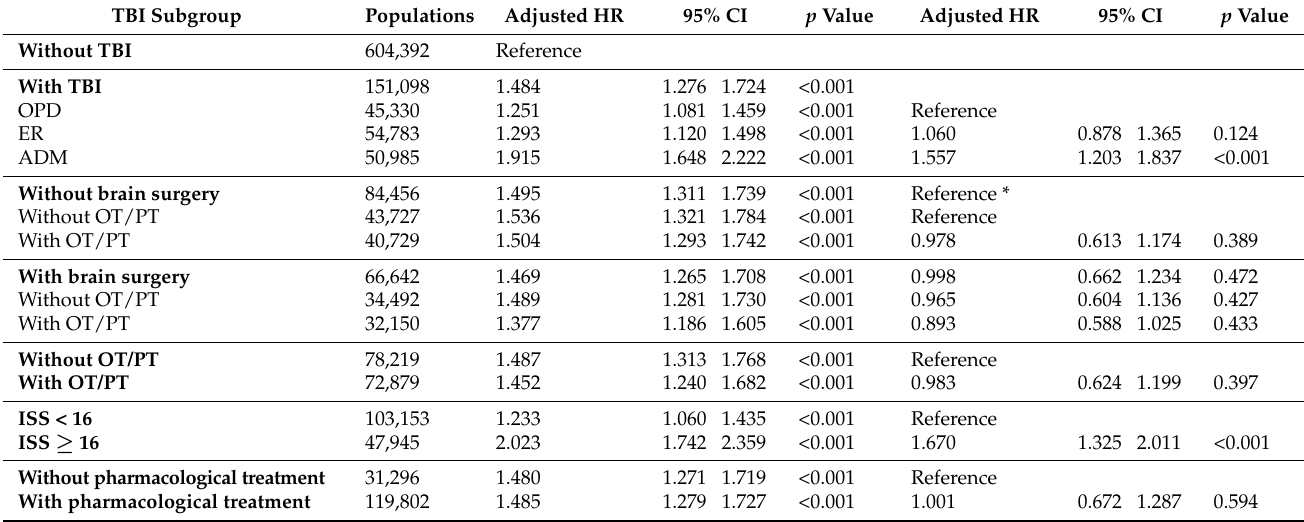
Table 4. Assessment of factors associated with the occurrence of migraine among different TBI subgroups using Cox regression